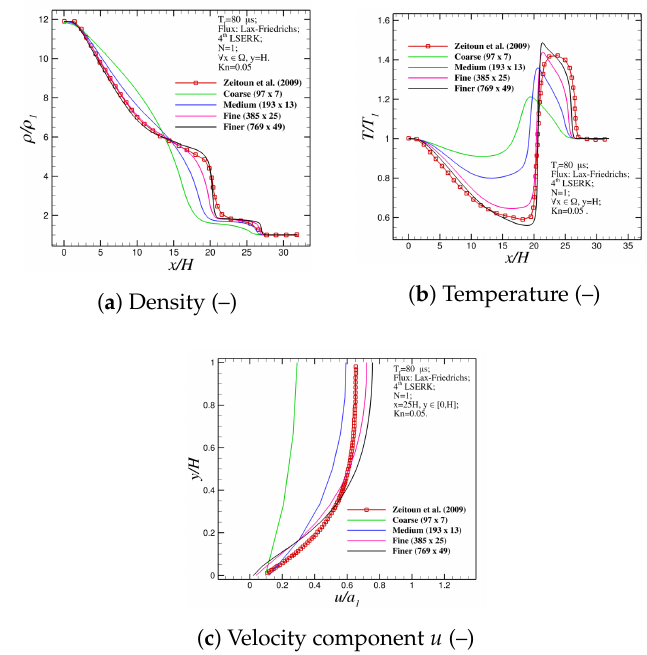
Figure 3. Dimensionless density ( a ); temperature ( b ) profiles in the centerline of the microchannel; and stream wise velocity u ( c ) in the cross section x = 25 H using four grid levels at the final time T f = 80 µ s with Kn = 0.05 in comparison with reference data of Zeitoun et al.